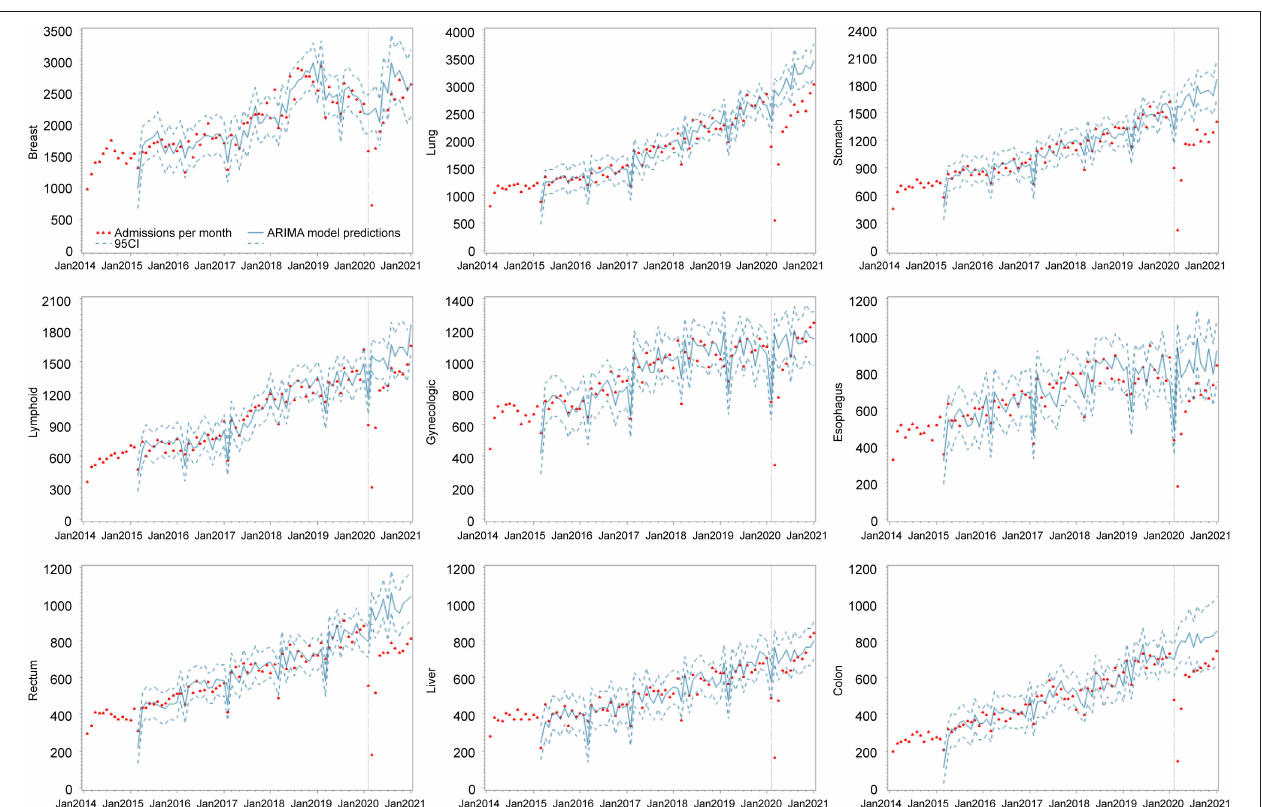
FIGURE 3 | Monthly admissions before and after the COVID-19 lockdown in Henan Cancer Hospital according to diagnosis. Breast: breast cancer; Lung: lung cancer; Stomach: stomach cancer; Lymphoid: lymphoid, hematopoietic, and related tissue cancers; gynecologic: female gynecologic cancers; Esophagus: esophageal cancer; Rectum: rectal cancer; Liver: liver and intrahepatic bile ducts cancers; Colon: colon cancer. Vertical lines represent change-point (lockdown). Fitted lines represent ARIMA regression models of the admissions. Surrounding dashed lines represent 95% confidence